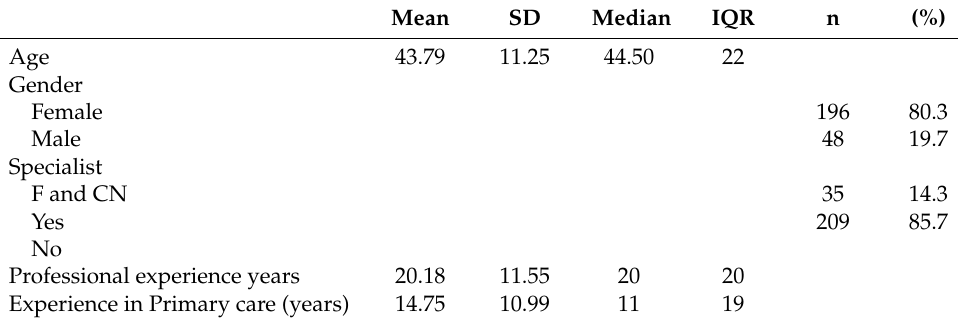
Table 1. Characteristics of the study population, Spain,